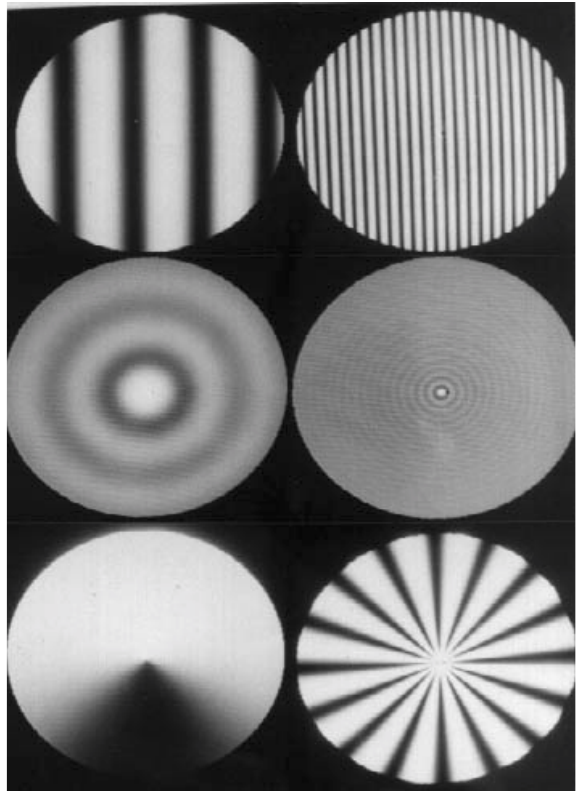
Figura 1. Exemplos de estímulos elementares de freqüências es- paciais grades senoidais (acima à esquerda 0,5 cpg e à direita 3 cpg), freqüências radiais, J (ao centro à esquerda 0,5 cpg e à direita 0 3 cpg) e freqüências angulares (embaixo à direita 1 ciclo e à esquer- da 16 ciclos). Estímulos originalmente calibrados para serem vis- to a 150 cm de distância antes de